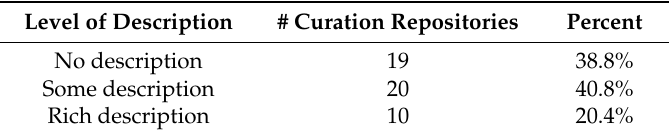
Table 4. Levels of description in the curation